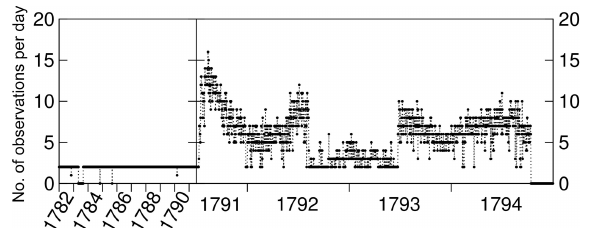
Figure 4. Number of observations per day. The horizontal scale is expanded for display purposes from July 1791